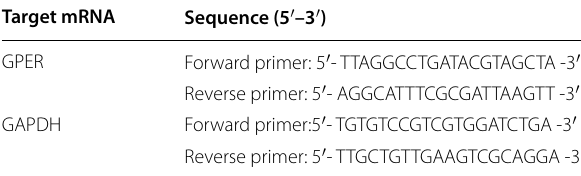
Target mRNA Sequence (5 ′ –3 ′